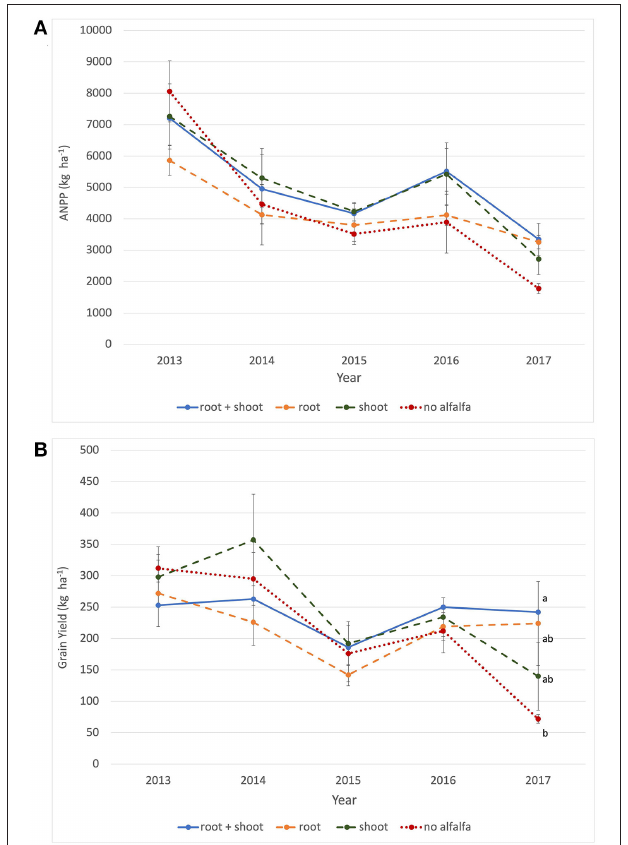
FIGURE 3 | Influence of above and belowground alfalfa biomass on IWG productivity. (A) Mean ANPP and (B) mean grain yield of IWG planted in 76cm rows with the following inter-row alfalfa additions: root + shoot, root only, shoot only, none. No within year differences of ANPP between treatments were found to be statistically significant. In grain yields, different lower-case letters represent significant differences within years ( P < 0.05) based on Tukey pairwise comparisons. Bars = 1S.E.